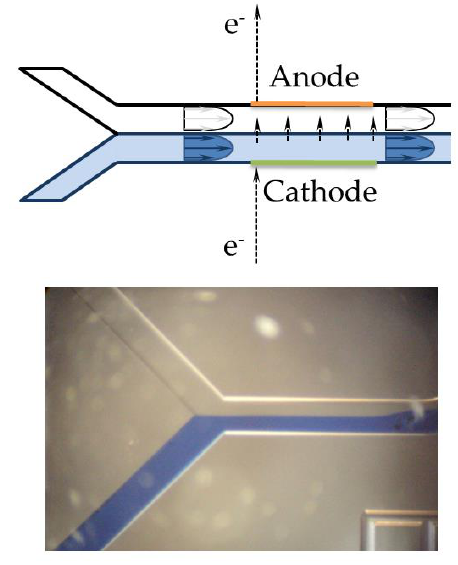
Figure 7. Microfluidic fuel cell (MFFC).